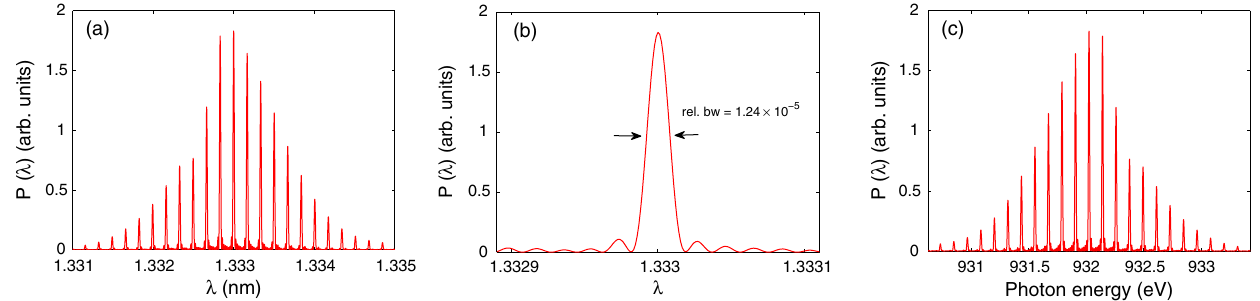
FIG. 3. FEL power spectrum as a function of x-ray wavelength (a); enlarged view of the central frequency line (b); FEL power spectrum as a function of x-ray photon energy